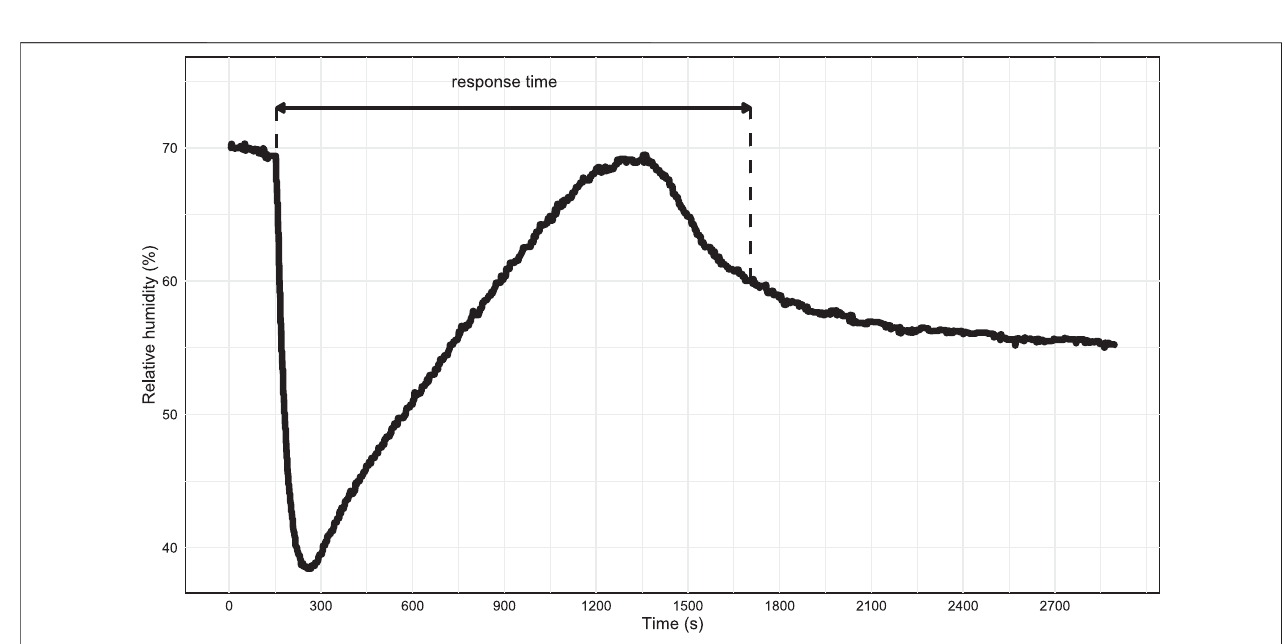
FIGURE7| Negativestep-changeofrelative humidity. Thetime axis represents time since thestartofthemeasurements(s).Thepeak present around1,300 sisa result ofameasurementerror generatedbythecondensationofwatervaporpresent intheairsurroundingthesmartphone, thiseffectprolongstheresponsetimeofthe sensor to a step-change in relative